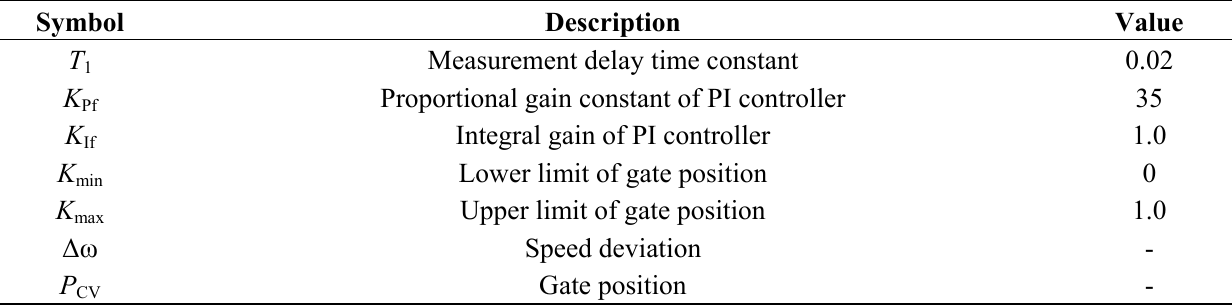
Table A2. Speed controller model symbols in Figure 11. PI: proportional integral.